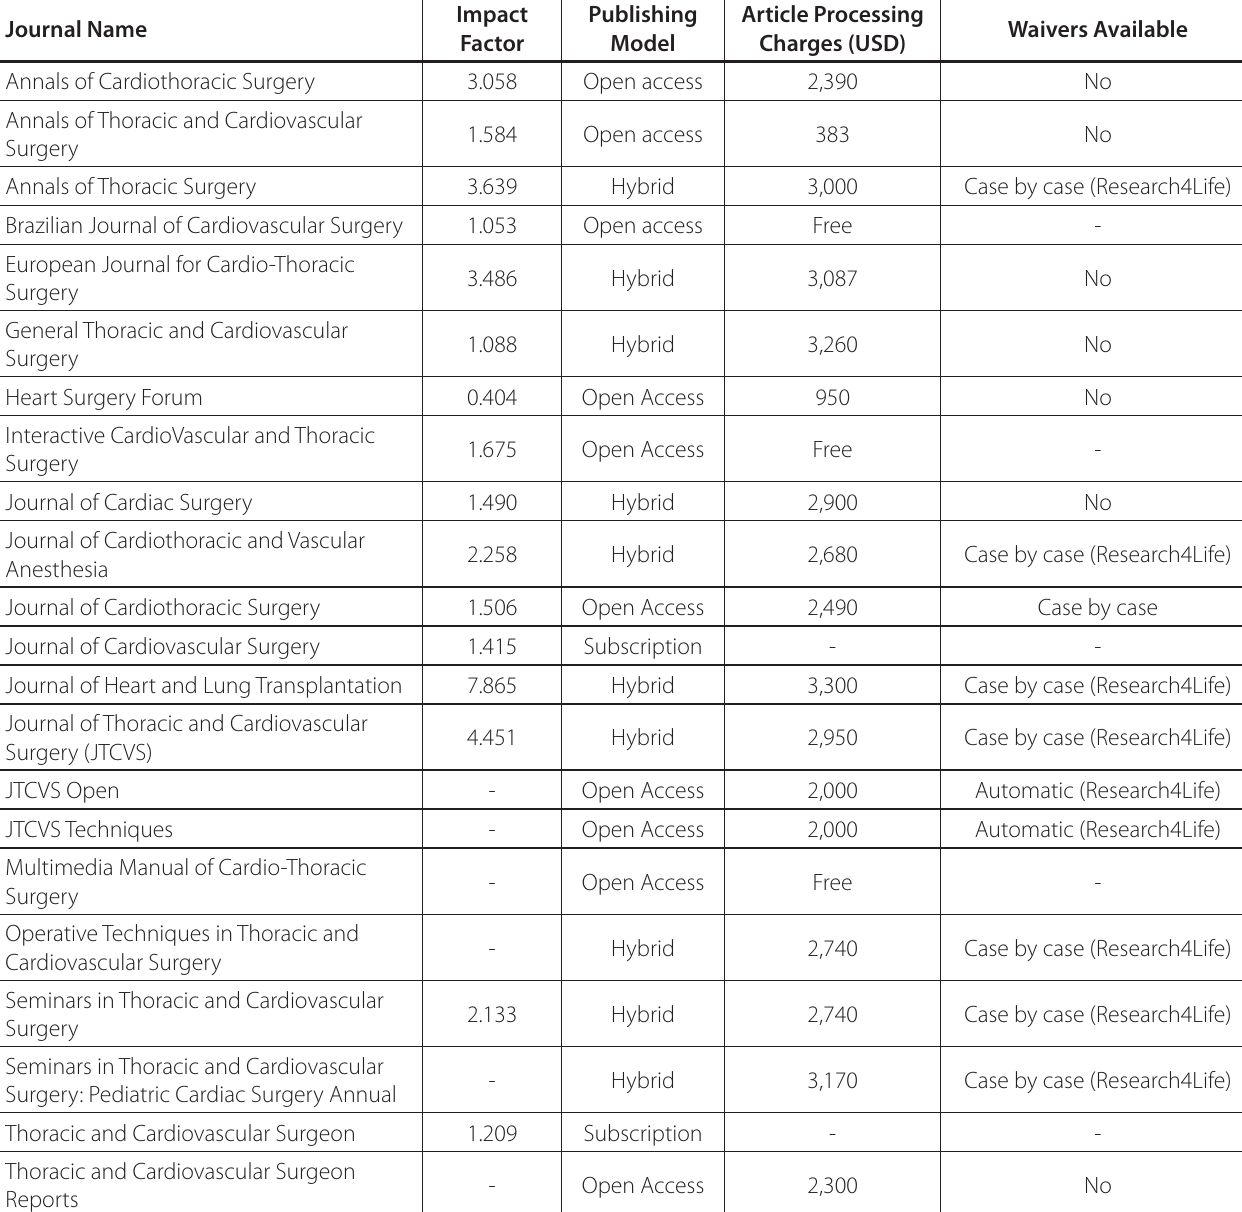
Supplemental Table 2. Publishing models and article processing charges for cardiac surgery journals indexed in InCites Journal Citation